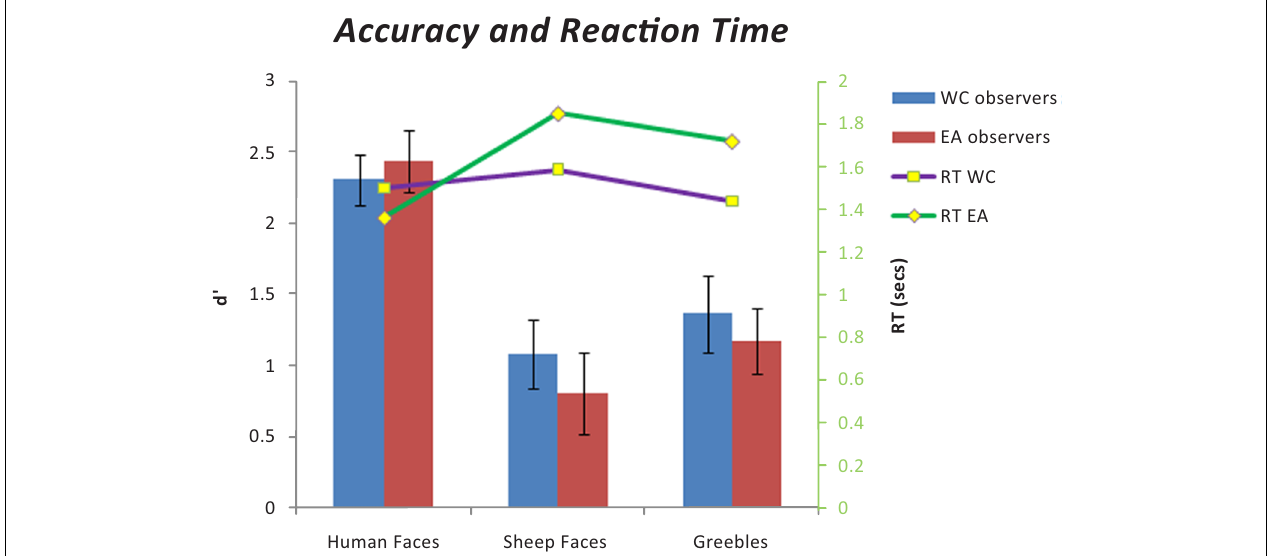
FIGURE 1 | Accuracy and reaction time for all stimulus